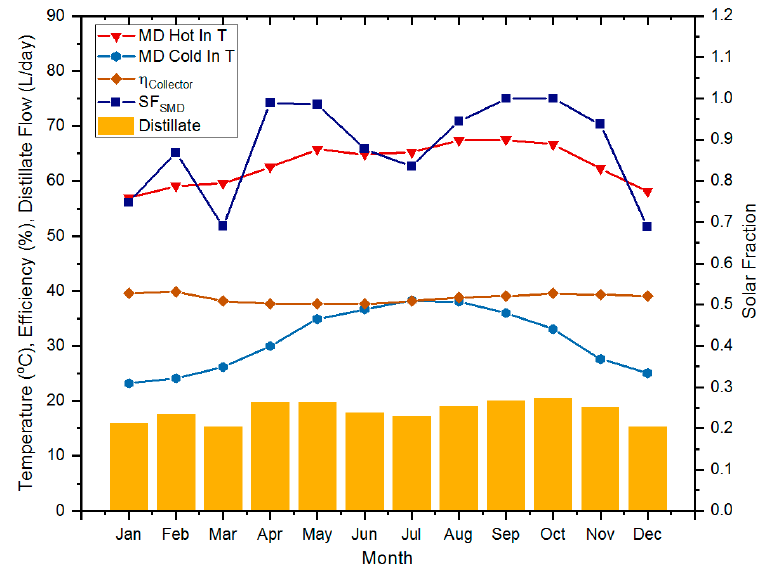
Figure 21. Annual simulation of SMD system operated in UAE.